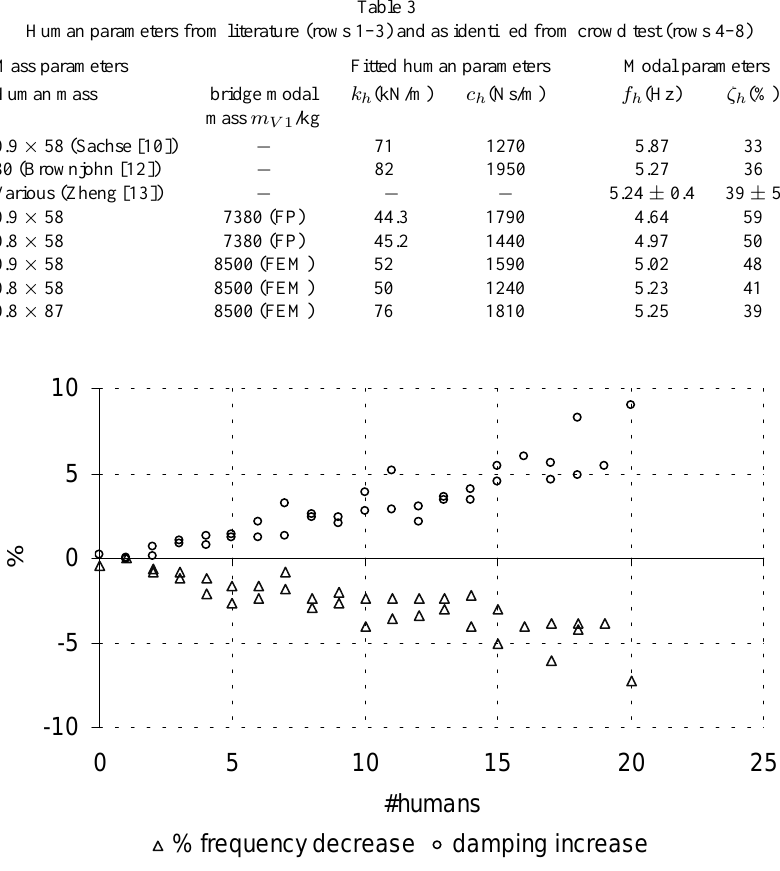
Fig. 13. Absolute changes in % damping and % changes in frequency due to human